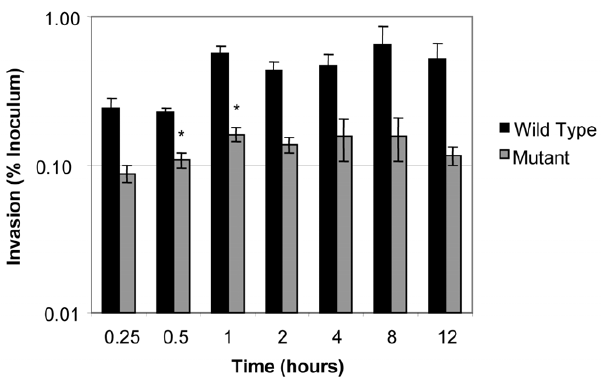
Figure 1. Invasion of bovine intestinal mucosa by S.enterica serovar Typhimurium. Data are plotted as the geometric means from four independent assays. The bars represent the standard errors. The percent invasion normalized to the inoculum for wild type S. Typhimurium is represented by the black bars and the D sipA , sopABDE2 mutant is represented by the grey bars. Asterisks indicate a significant difference in invasion compared with the wild type positive control ( p # 0.05).